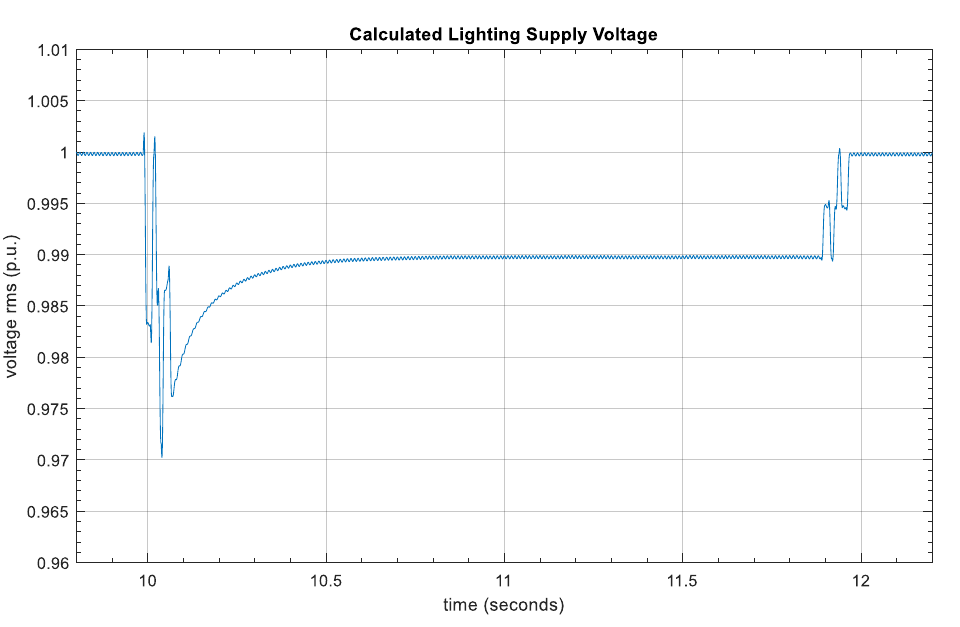
Figure 9. Laser printer current during multiple copying cycles, used for simulation.